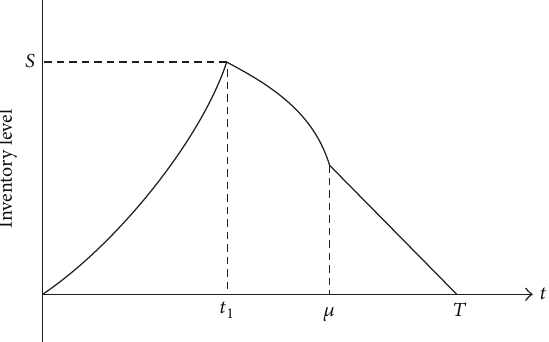
Figure 2: The inventory model for 𝑡 1 ≤ 𝜇